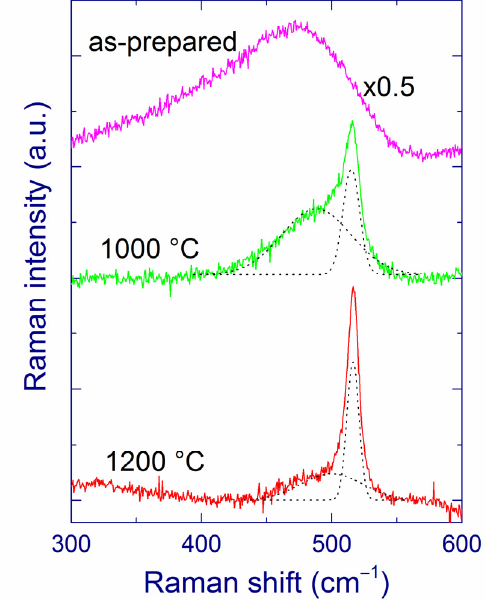
Figure 1. Raman spectra of a SiO 1.75 film as-prepared and annealed at 1000 and 1200 °C (fitted by two Gaussians). The spectra are vertically shifted for better presentation. The Raman spectra are measured with laser intensity of ~10 3 W cm –2 at the sample. Reproduced with permission from [116]. Copyright 2012, AIP Publishing